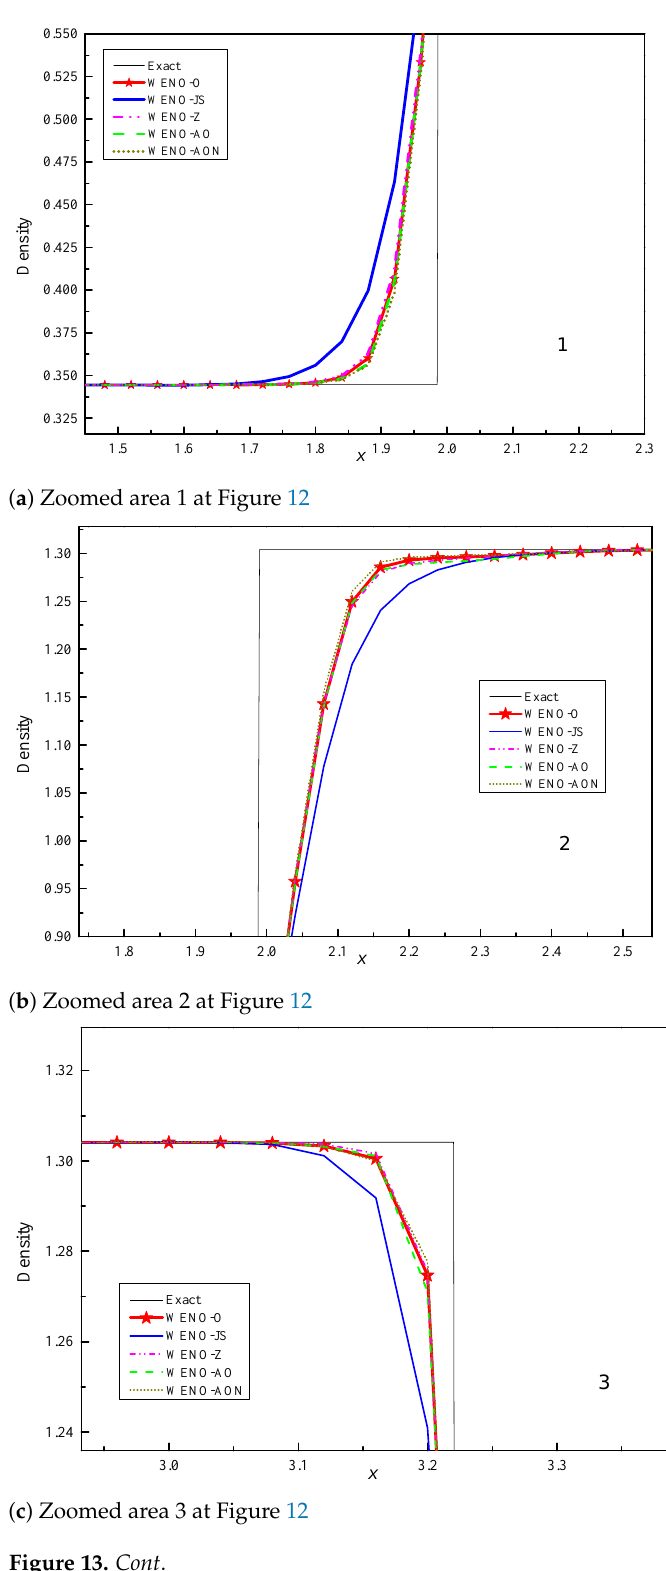
( c ) Zoomed area 3 at Figure 12 Figure 13. Cont